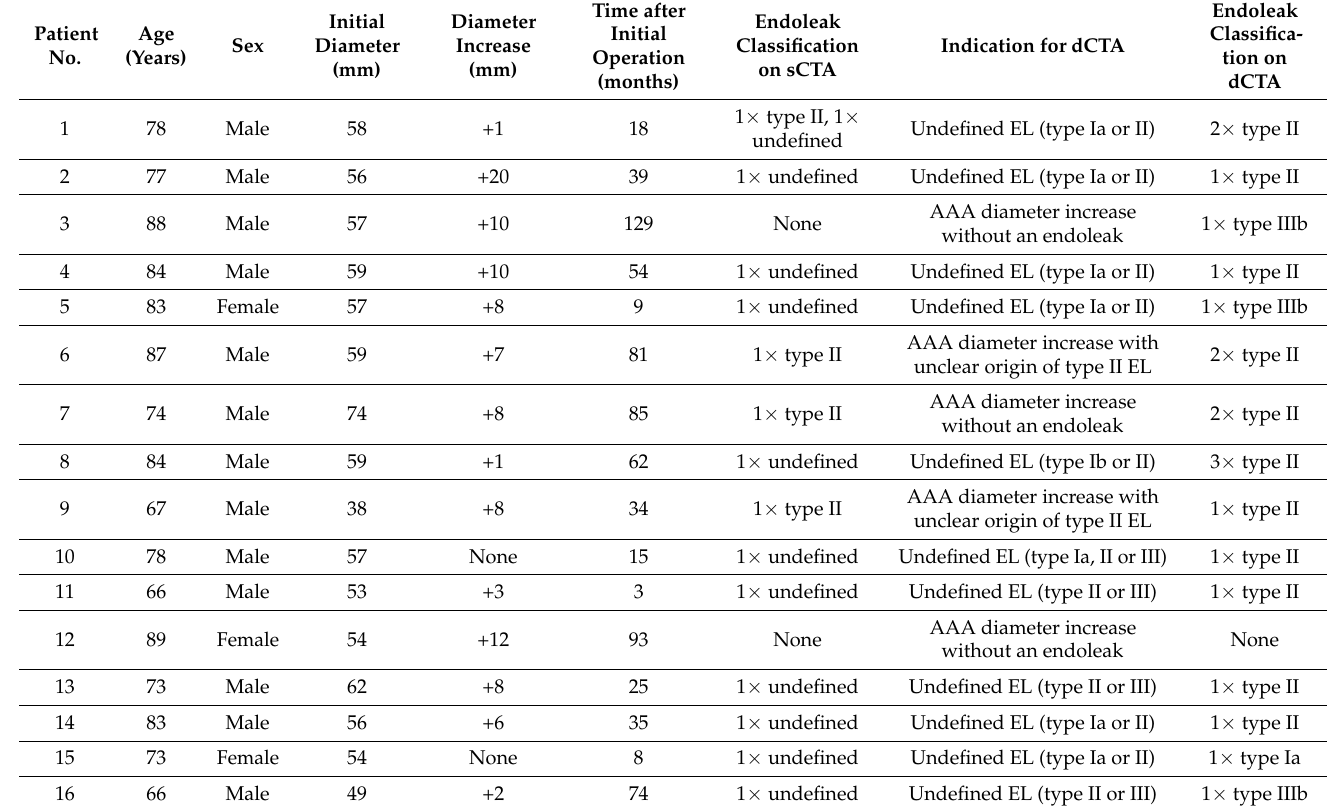
Table 1. Patients’ characteristics, sCTA and dCTA. sCTA = standard computed tomography angiogra- phy. dCTA = dynamic computed tomography